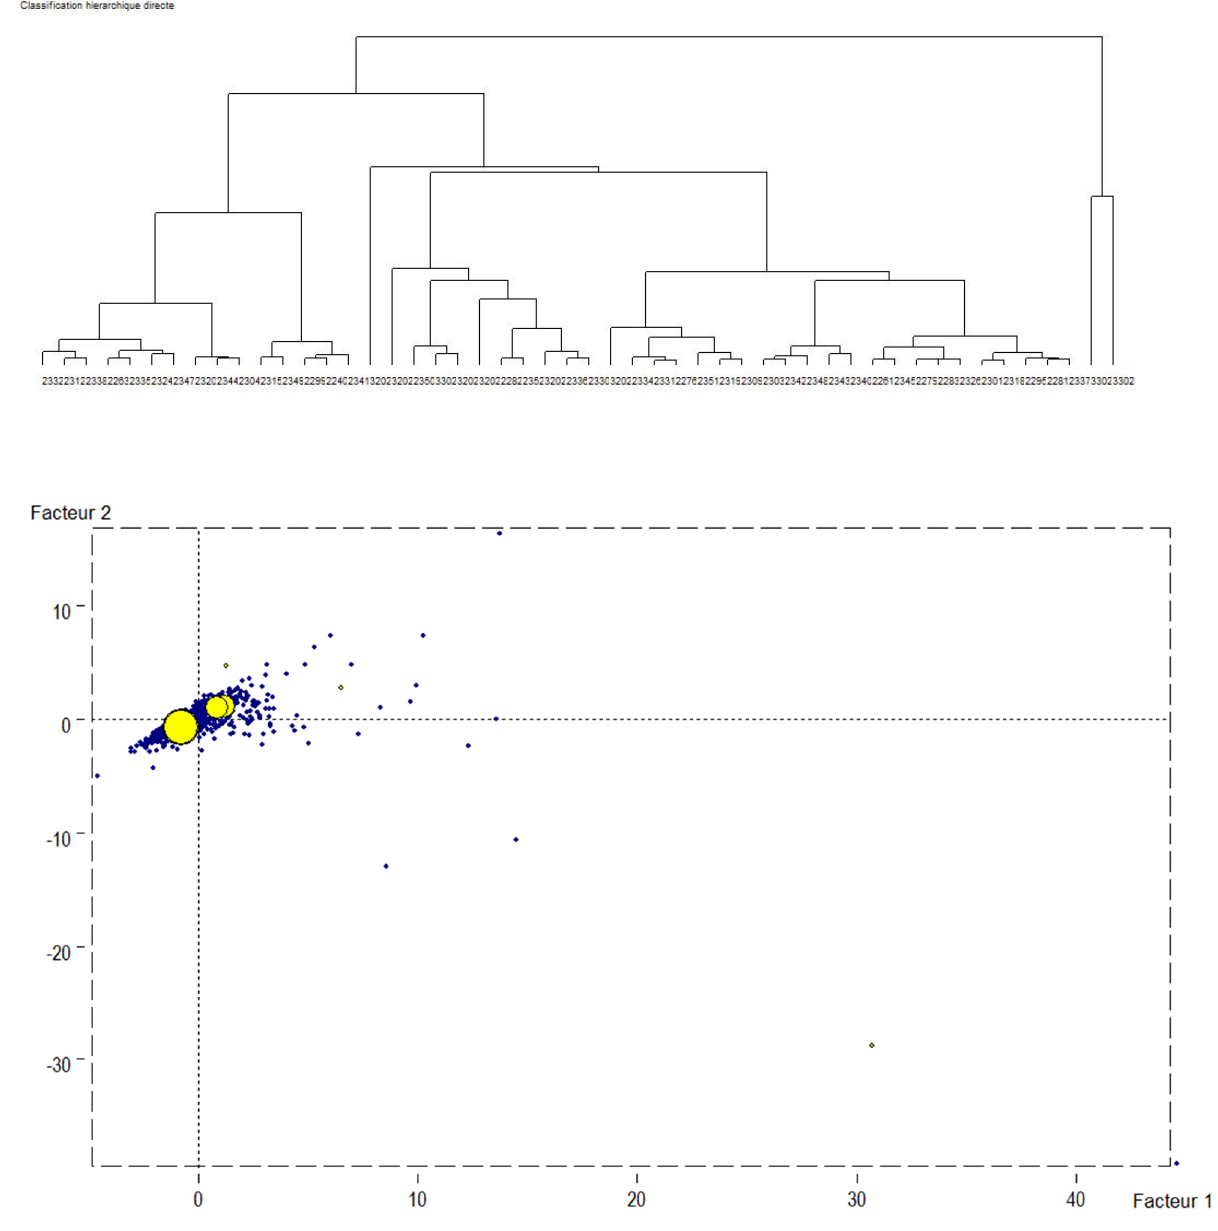
Figure A5. Cluster analysis dendrogram and graph for the islands geographic distribution.